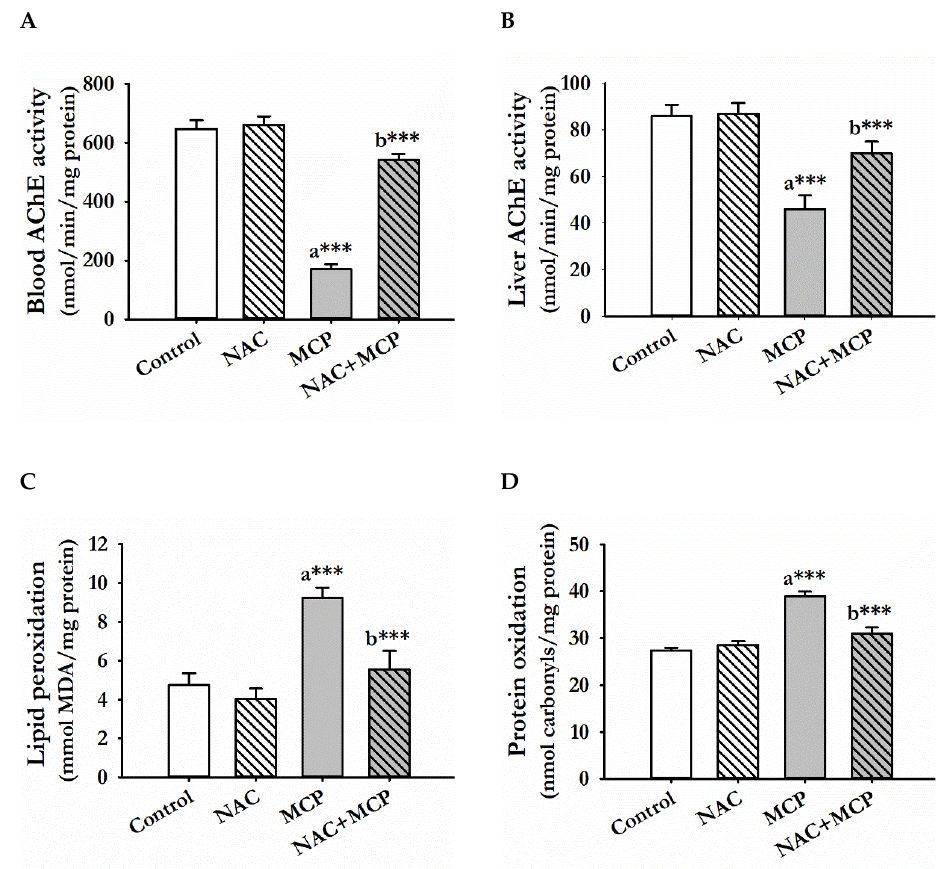
Figure 1. NAC pre-treatment restored AChE activity and prevented oxidative stress in the liver of MCP-exposed rats. ( A , B ) Enzymatic activity of AChE in the serum and liver tissue, ( C ) levels of MDA and ( D ) carbonyl content in the liver tissue of the different experimental groups. The values represented are mean ± S.D. (N = 5). a as compared to the control group; b as compared to MCP-exposed group. *** p < 0.001, significantly different.